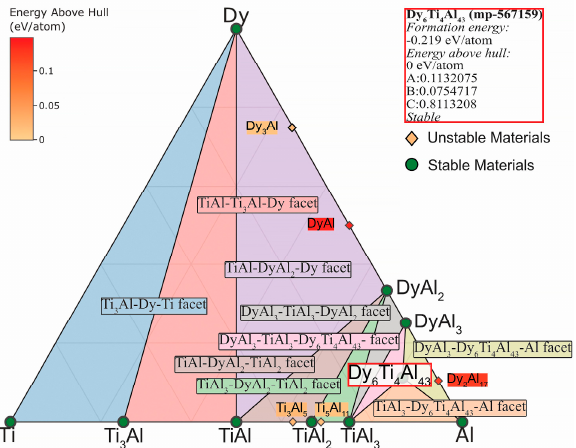
Figure 7. Ti-Al-Dy phase diagram at a temperature of 1150 ° С .